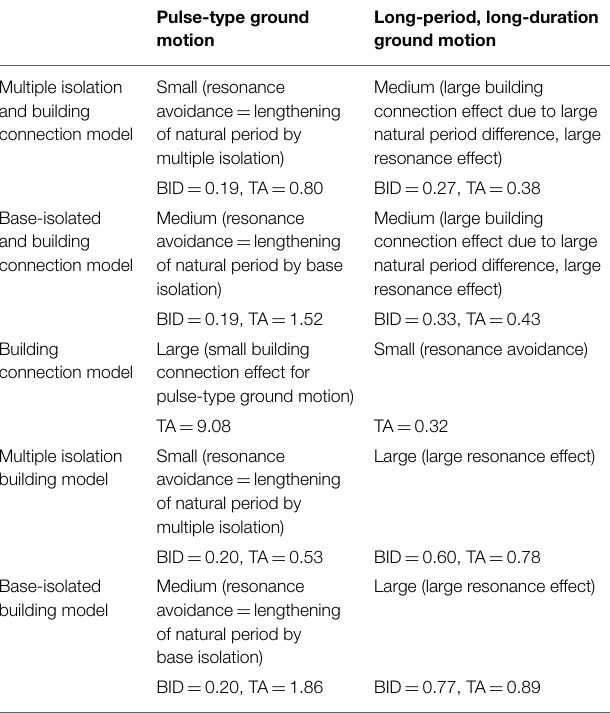
TABLE 3 | Comparison of the first three natural periods and damping ratios between the standard model and the optimal design